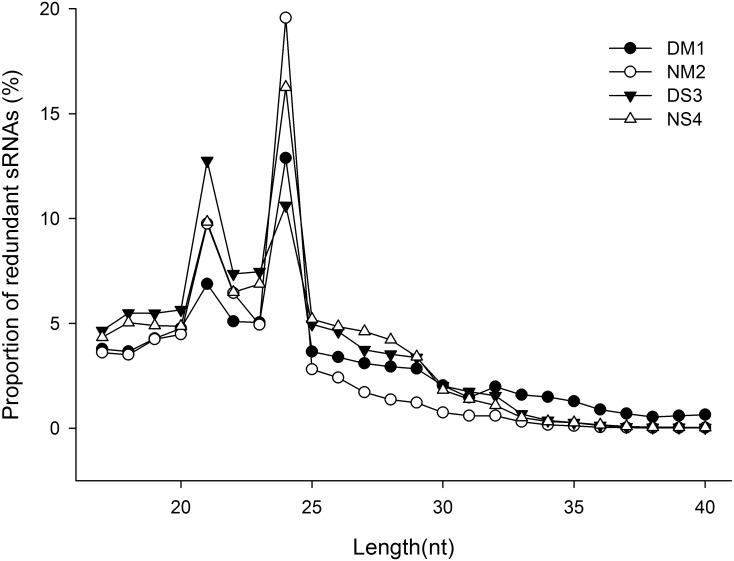
Distribution of sRNAs detected in four alfalfa libraries.The length distribution of sRNA reads in dormant alfalfa (DM1, and DS3) and non-dormant alfalfa (NM2, and NS4) were detected with Solexa technology.